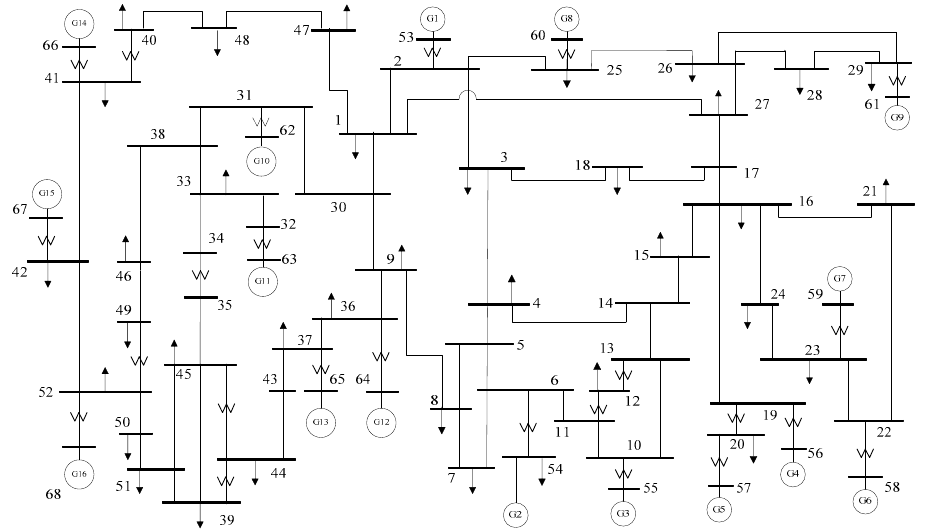
Figure 2. The 68-bus New England test system (NETS)–New York (NYPS) interconnected system.